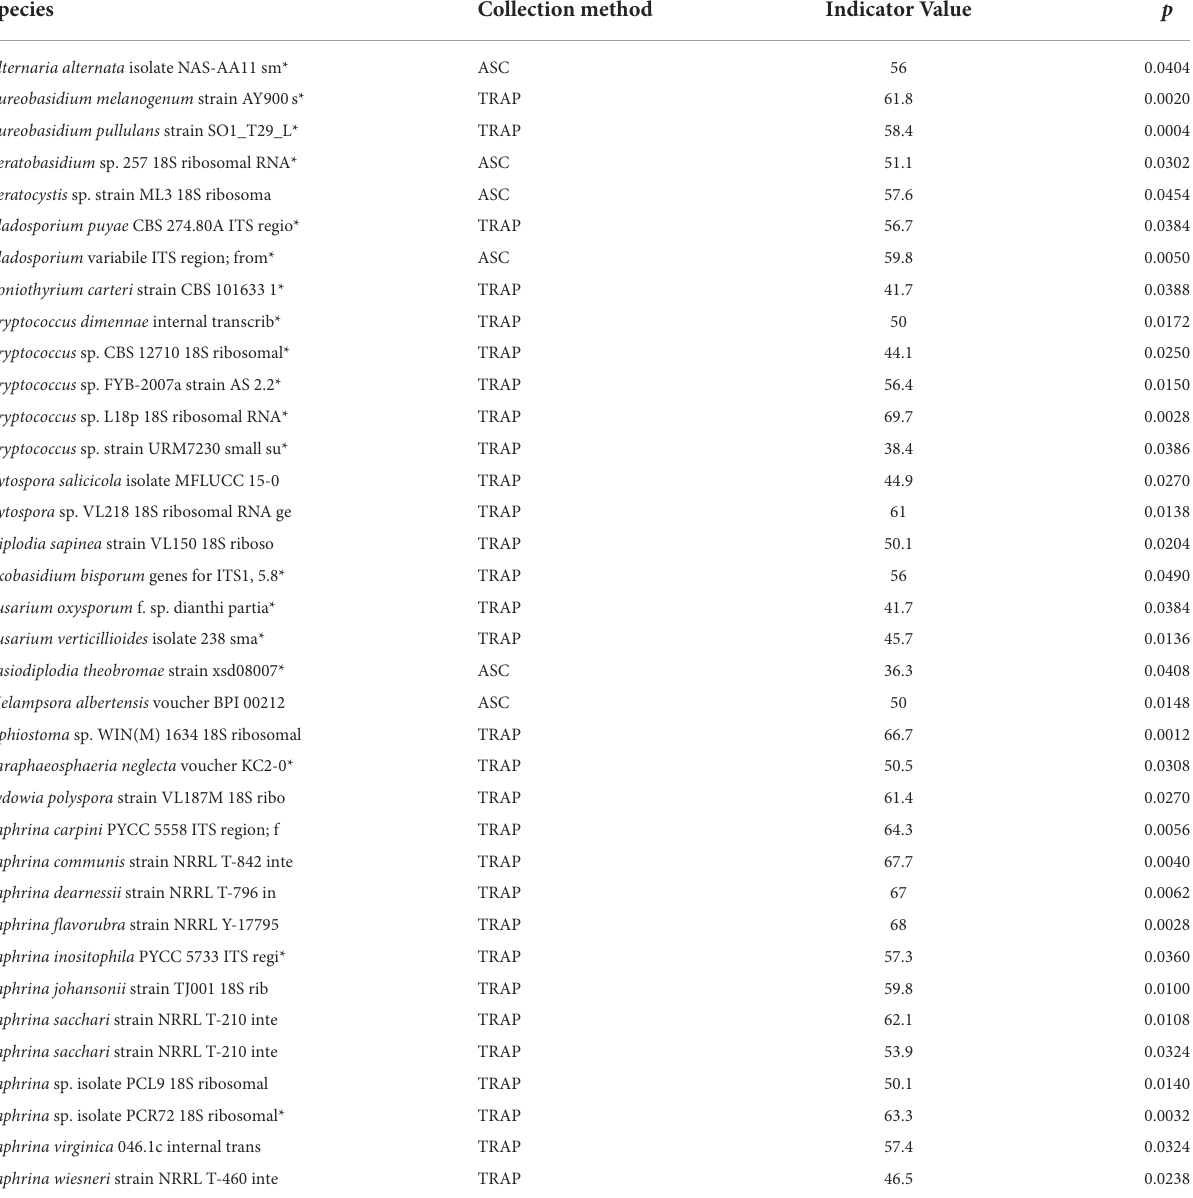
TABLE 4 Results of indicator species analysis show the species of plant pathogenic fungi are significantly more abundant and consistently associated with either aerial spore collectors or Lindgren funnel traps.